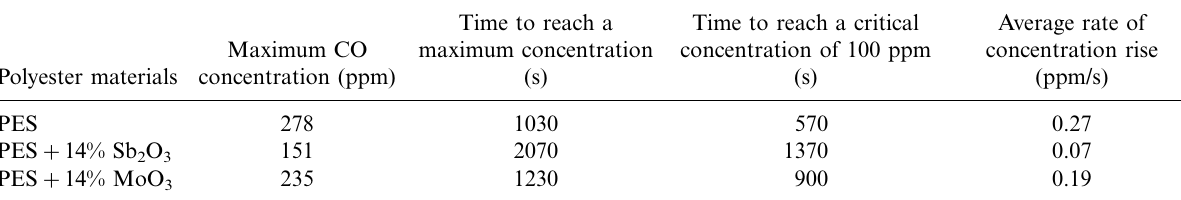
Table 3. Basic parameters characterising CO distribution during the combustion of modified and unmodified polyester